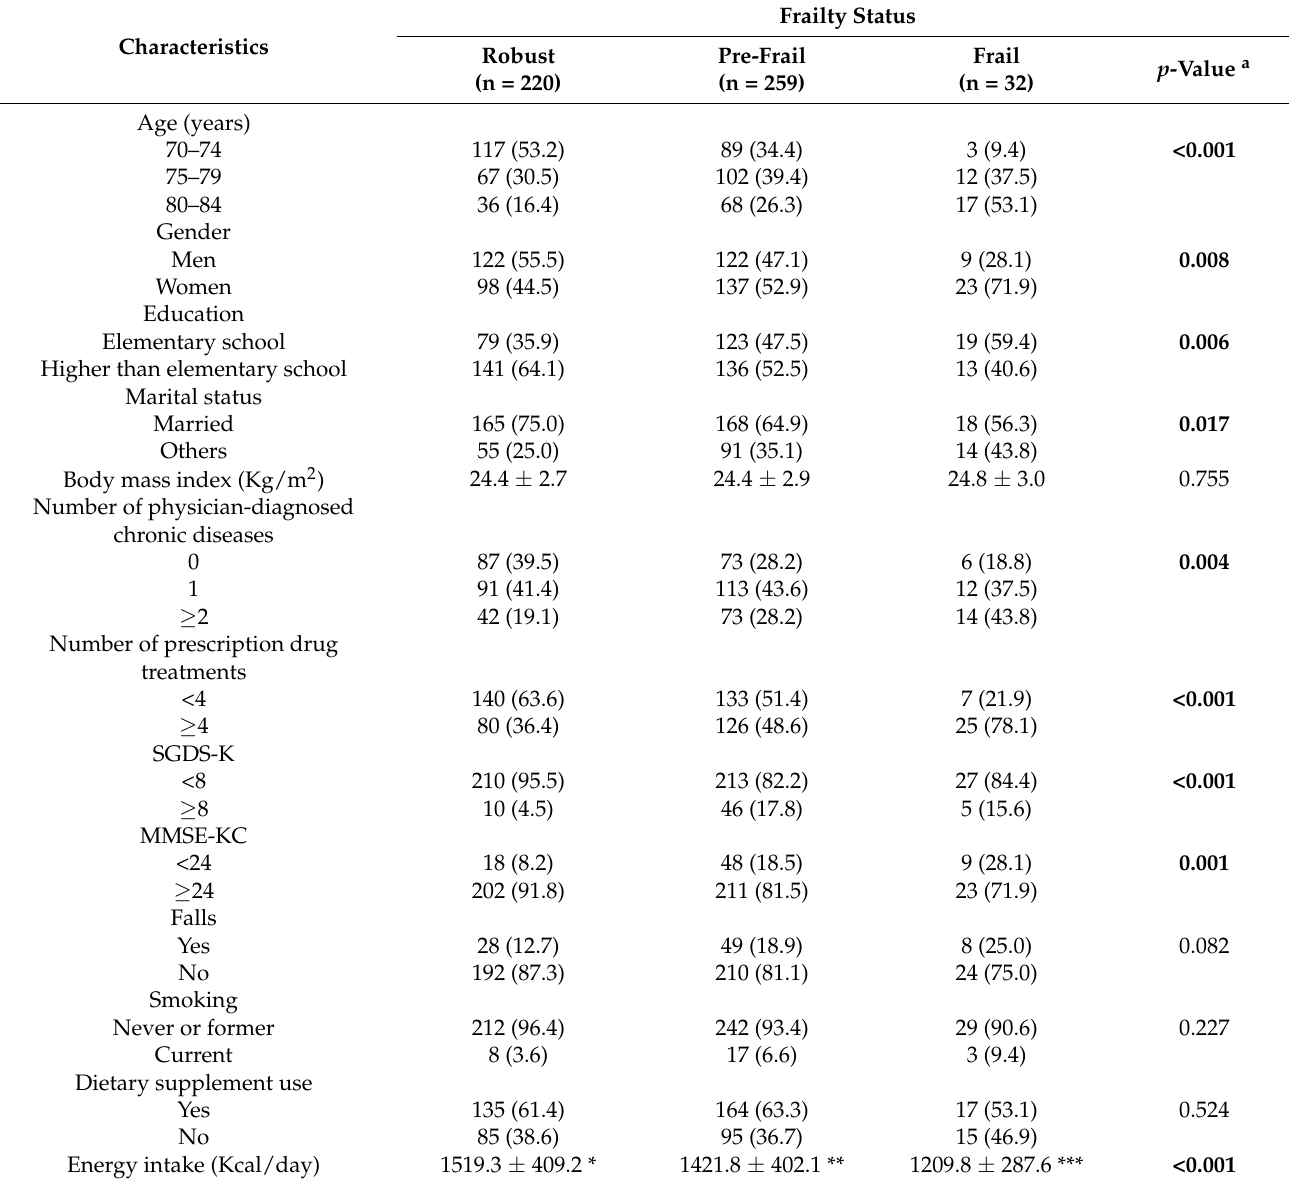
Table 3. Relationship between frailty status and subject characteristics ( n =